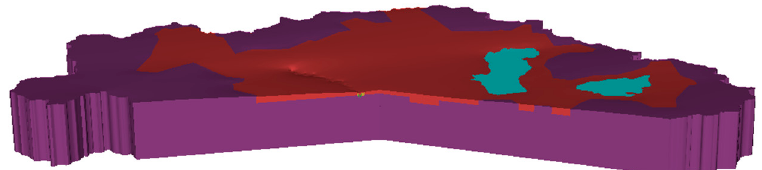
Figure 4. Geometry of the granular (red) and fractured media (dark magenta), the hydraulic con-